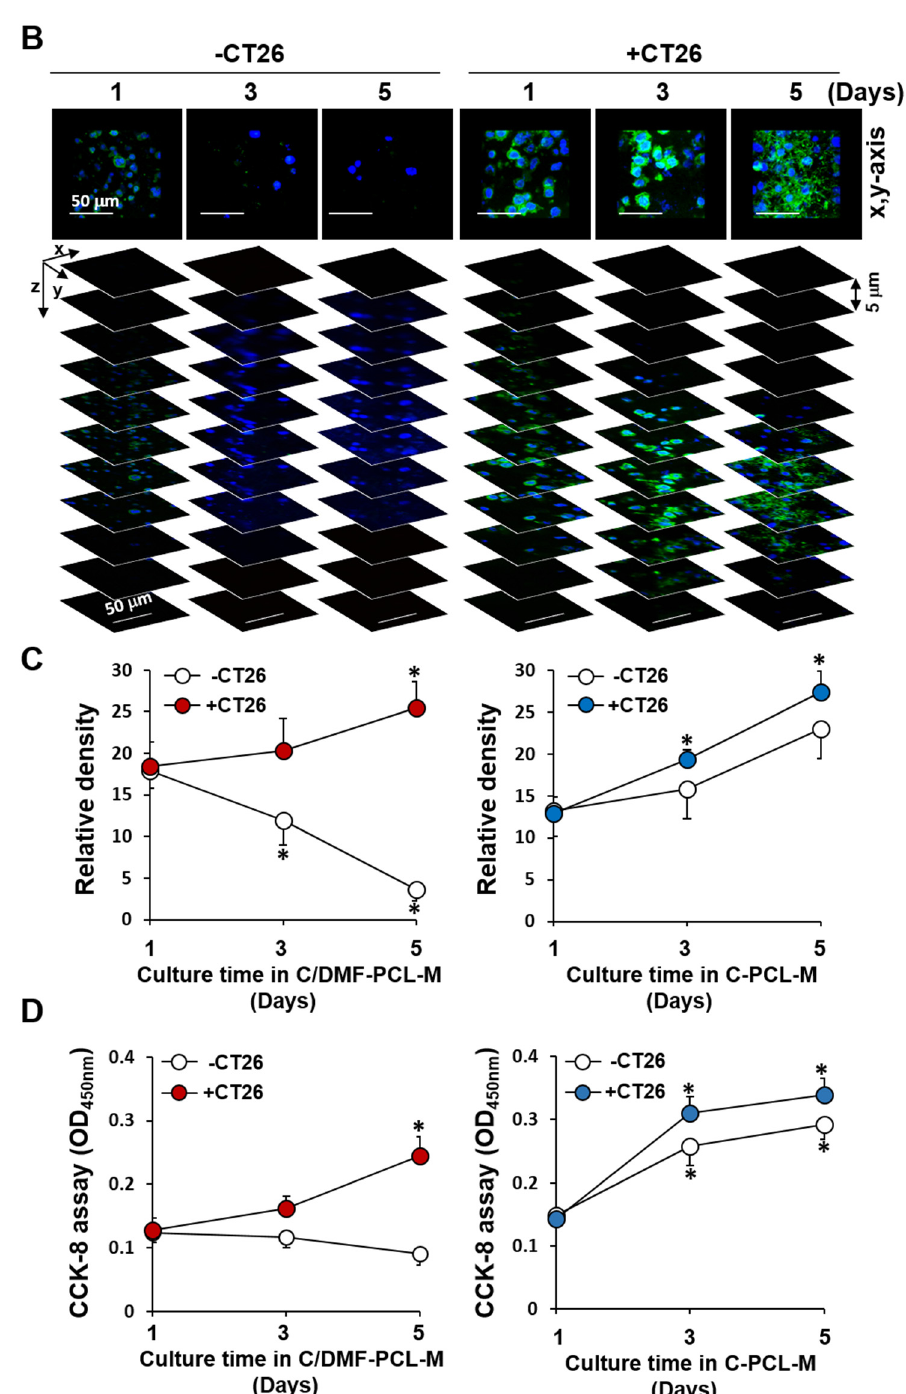
Figure 4. Enhanced growth of bEND.3 ECs co-cultured with CT26 cancer cells on C / DMF-PCL-M in a two-layer culture system. bEND.3 cells (3 × 10 4 ) were top-seeded on either C / DMF-PCL-M or C-PCL-M in the upper layer and cultured with ( + CT26) or without ( − CT26) CT26 cells (3 × 10 4 ) on the C-PCL-M in the lower layer as shown in the supplementary Figure S1. Cells were cultured for the indicated periods ( n = 3) and stained with fluorescently labeled antibodies. ( A ) Cell distribution and morphology were assessed via confocal microscopy. Images represent three fields in each membrane. ( B ) Cellular localization in the nanofibrous sca ff old was evaluated by focus-stacking images of the cell-sca ff old construct ( n = 3). ( C ) The intensity of red fluorescence was analyzed using ImageJ software. ( D ) Proliferation rates of the cells were analyzed using the CCK-8 assay. Data are presented as mean ± SD values ( n = 3).* p < 0.05, compared to d 1.